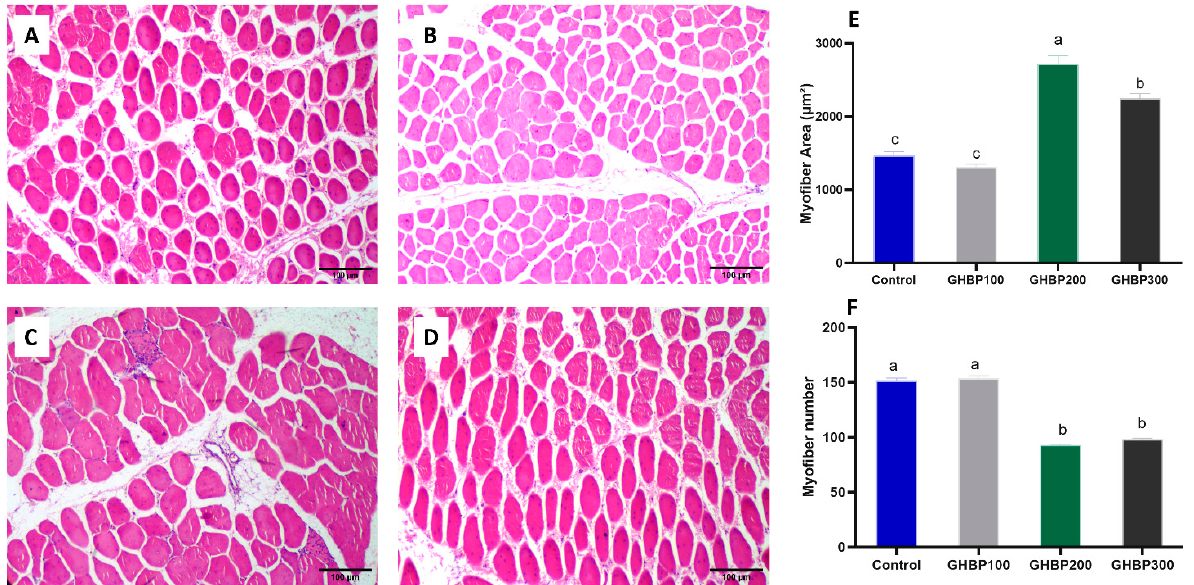
Figure 4. Breast muscle histological cross sections of broiler chickens supplied with GHBP: control ( A ), GHBP100 ( B ), GHBP200 ( C ), and GHBP300 ( D ). Muscle fiber’s characteristics: myofiber area ( µ m 2 ) ( E ) and myofiber number per field ( F ). GHBP: growth hormone-boosting peptide. Data are expressed as means ± SE. Bars with different letters above them correspond to values that were significantly different ( p < 0.05). Control: basal diet without GHBP; GHBP100: basal diet plus GHBP at a level of 100 μ g/kg; GHBP200: basal diet plus GHBP at a level of 200 μ g/kg; GHBP300: basal diet plus GHBP at a level of 300 μ g /kg. a,b,c, Means with different superscripts within the same row differ significantly ( p < 0.05).